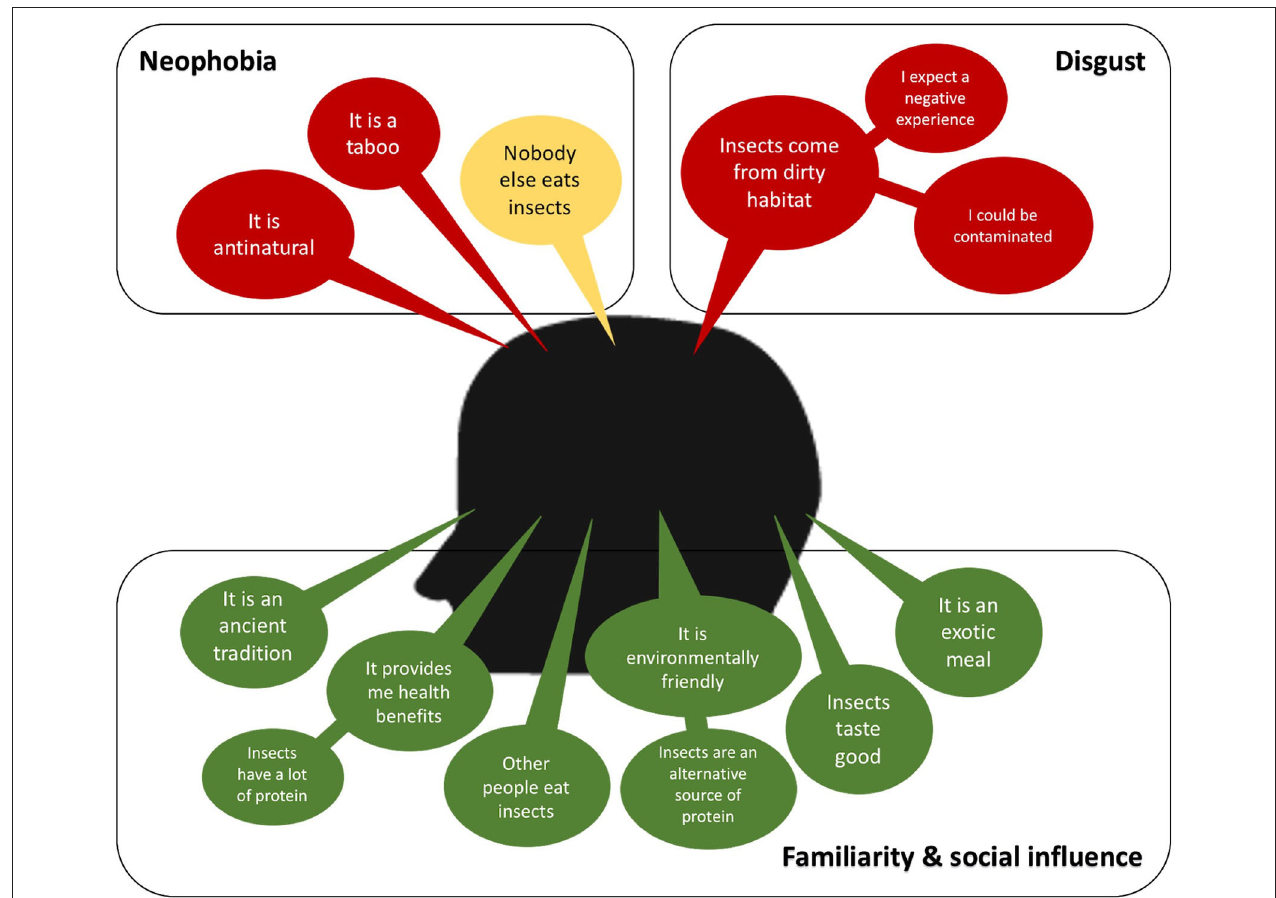
FIGURE 1 | A consumer-perception diagram. A positive consumer-perception is colored in green, neutral is in yellow and negative is in